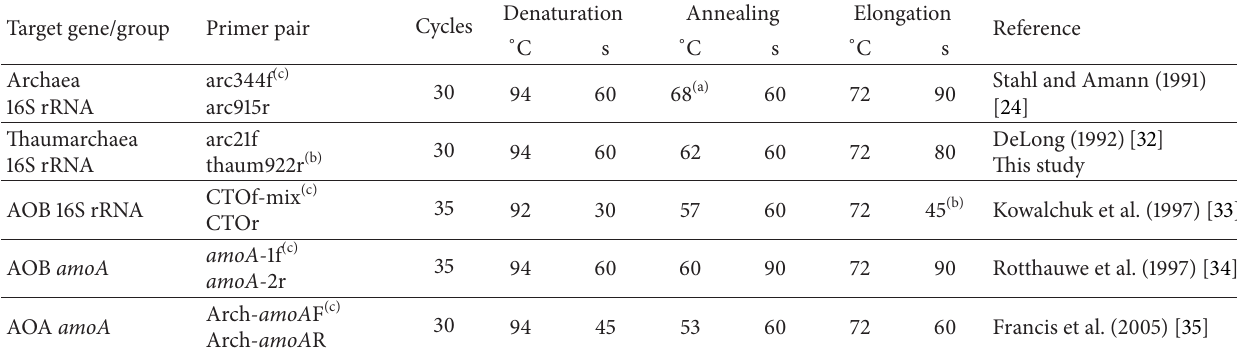
Table 2: Primer sets and conditions used for 16S rRNA and AmoA genes amplification and cloning of ammonia-oxidizing prokaryotes. An initial denaturation (94 ∘ C for 5 min) and final elongation (72 ∘ C for 20min) steps were performed to all reactions. (a) Touchdown 0.5 ∘ C per cycle, from at 68 ∘ C to 60 ∘ C; (b) +1sec per cycle. Final elongation = 5 minutes. (b) New: reverse primer, specifically targeting